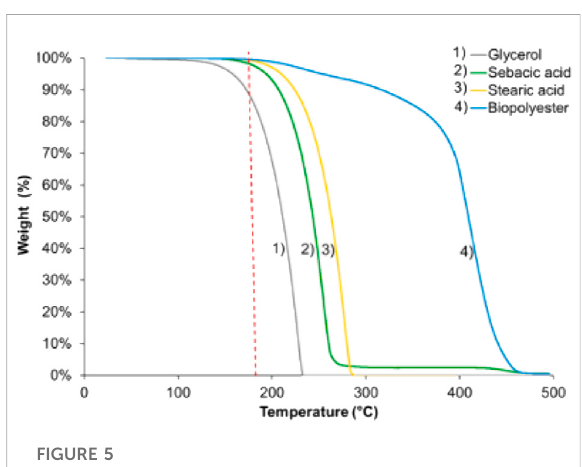
FIGURE 5 Thermogravimetric analysis: variation in reagent weight and biopolyestersundernitrogen fl owwithaheatingrampof10 ° C/min (Coativy et al.,